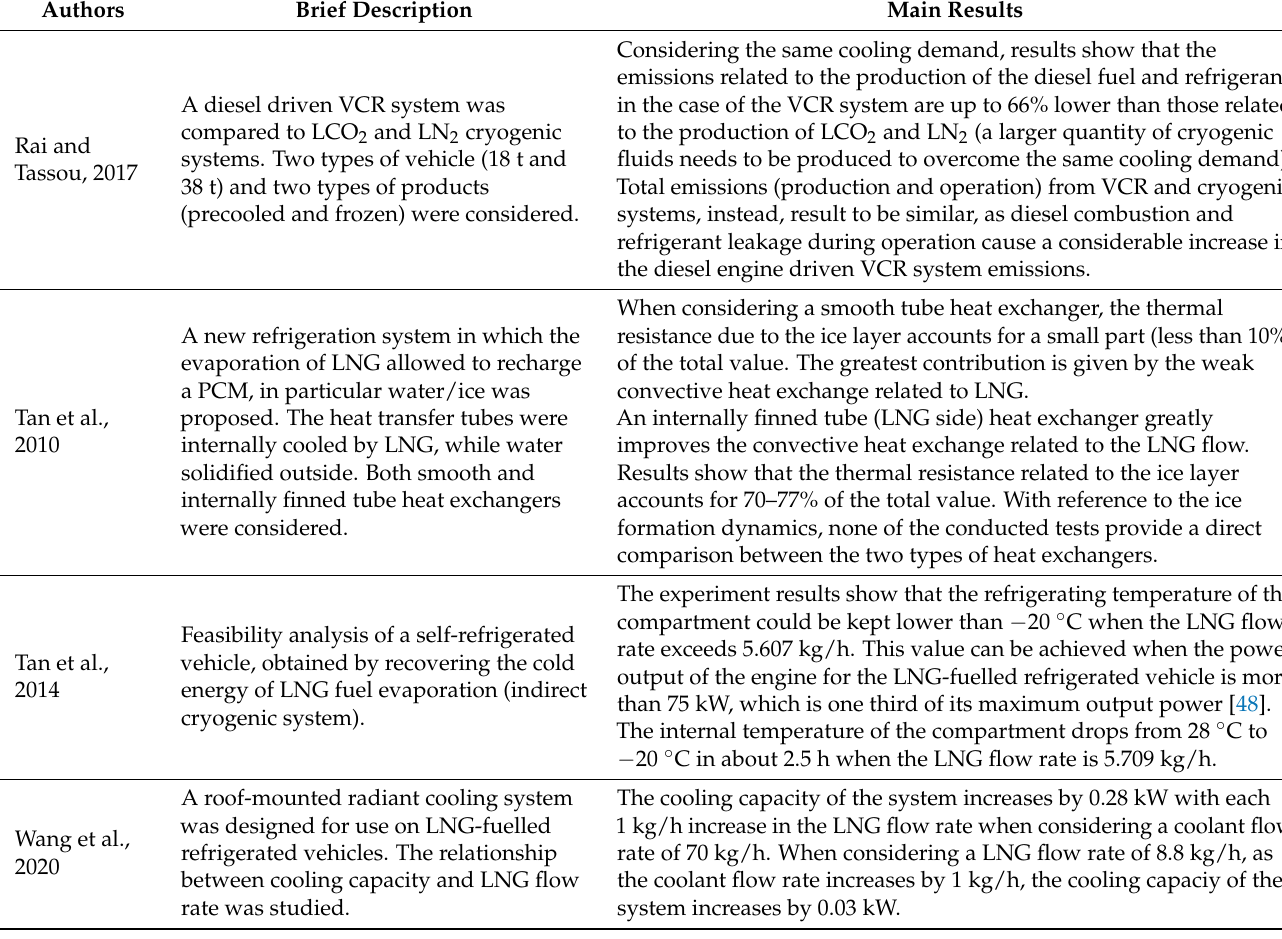
Table 4. Summary of proposed cryogenic systems in refrigerated transport